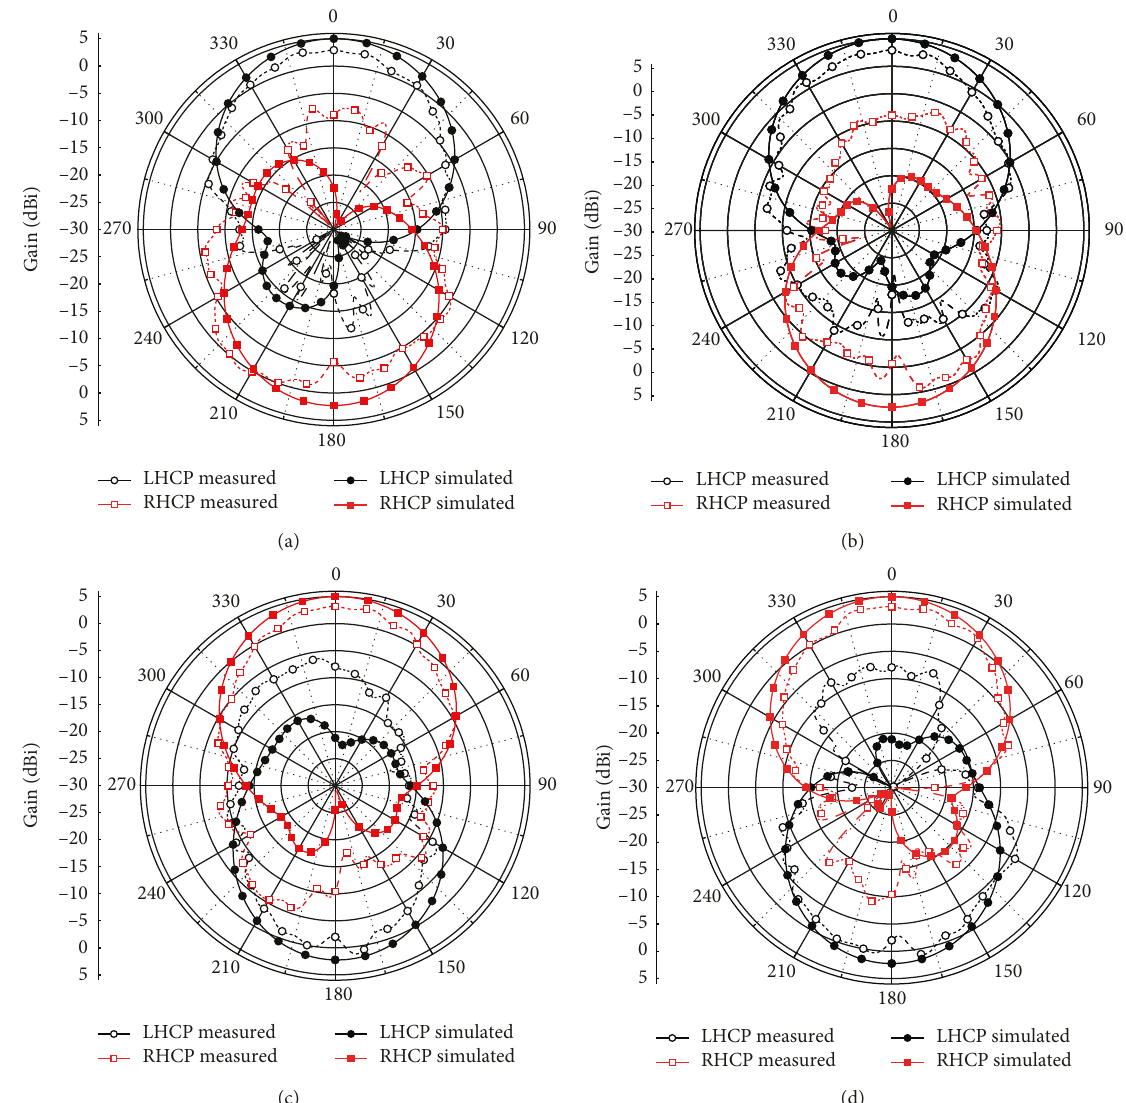
Figure 9: Simulated and measured radiation pattern at 1.74GHz: (a) state 1 with φ � 0 ° , (b) state 1 with φ � 90 ° , (c) state 2 with φ � 0 ° , and (d) state 2 with φ � 90 °